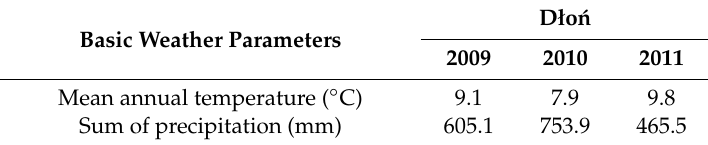
Table 2. Meteorological conditions in Dło´n, during the vegetation season of winter oilseed rape in 2009, 2010 and